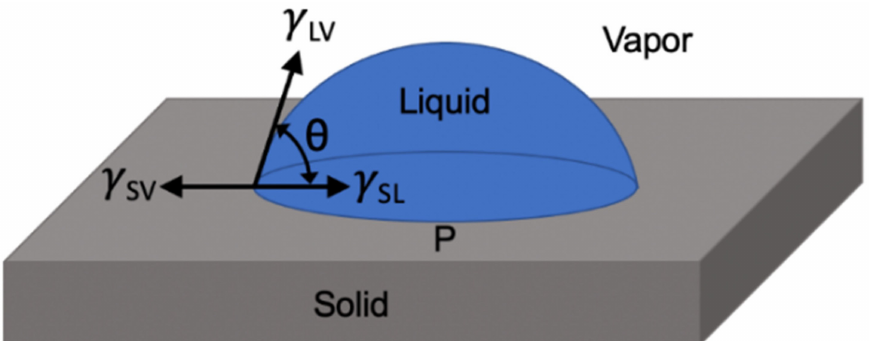
Figure 3. Schematic illustration of a liquid drop on a smooth solid surface surrounded by a vapor phase. The interfacial energies associated with the 3 phases include solid–liquid, γ SL , solid–vapor, γ SV , and liquid–vapor, γ LV . The WCA, θ , is measured at the 3-phase contact line, P, from the solid–liquid interface to the liquid–vapor interface within the liquid